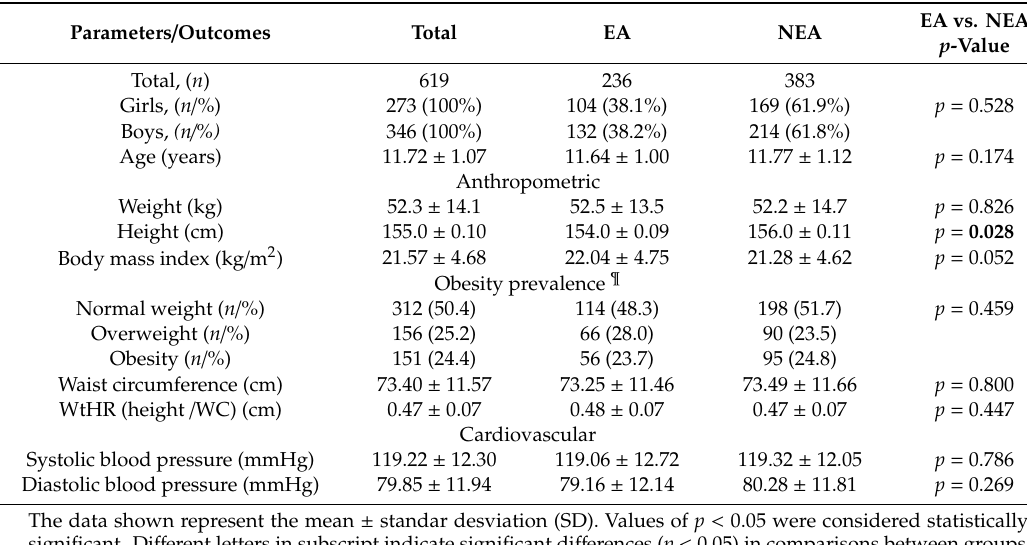
Table 1. Baseline characteristics of the schoolchildren participants by ethnic groups at the level of anthropometry, physical fitness, cardiovascular, lifestyle and health-related quality of life